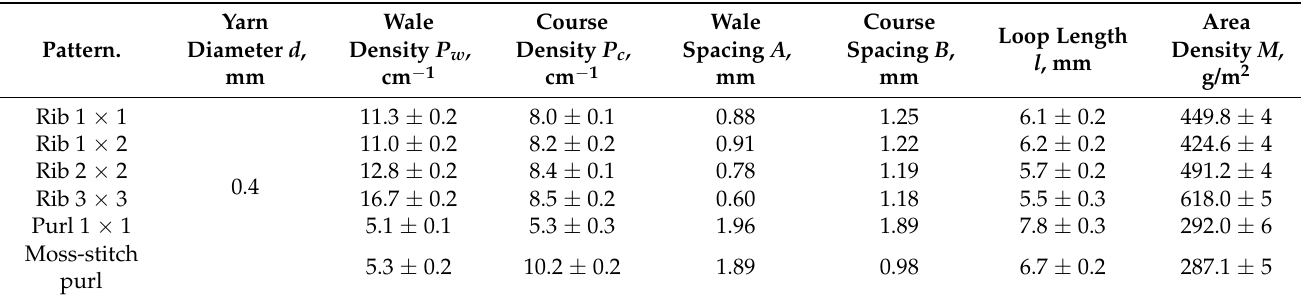
Table 1. Structural parameters of the knits.